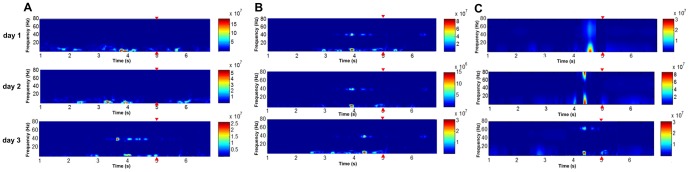
Time-frequency spectra of LFPs while rat in a WM task.Spectral peaks of the gamma and theta rhythms stand out as isolated spots (arrows). The gamma rhythms slow down gradually from 55.0 Hz and 75.0 Hz while theta rhythms slow down gradually from 3.0 Hz and 10.0 Hz. The time interval of LFPs was 2 s before WM reference and 1 s after WM reference. Time is presented on the x-axis. Frequency is presented on the y-axis. The width of each spectral segment was 7 s, and the frequency ranges was 1–80 Hz. (A) denote time-frequency spectra of PRO group in the first day, the second day and the next day after propofol anesthesia. (B), (C) respectively denote time-frequency spectra of control group and pro group at the same time. The energy level is coded on a color scale: blue areas show low energy, and red areas show high energy. Control  =  no propofol anesthesia; pro = 0.5 mg•kg−1•min−1, 2 h; PRO = 0.9 mg•kg−1•min−1, 2 h. ▾▴ represents the tripping time by infrared in Y-maze.